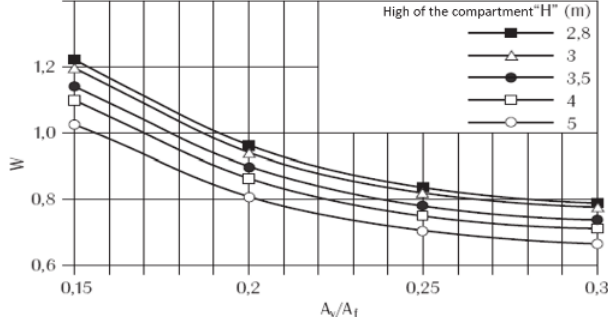
Figure 4 Values of H in function of the ventilation A and compartment height